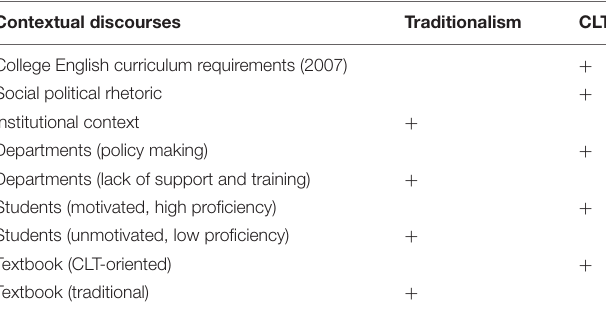
TABLE 3 | Heteroglossia of contextual